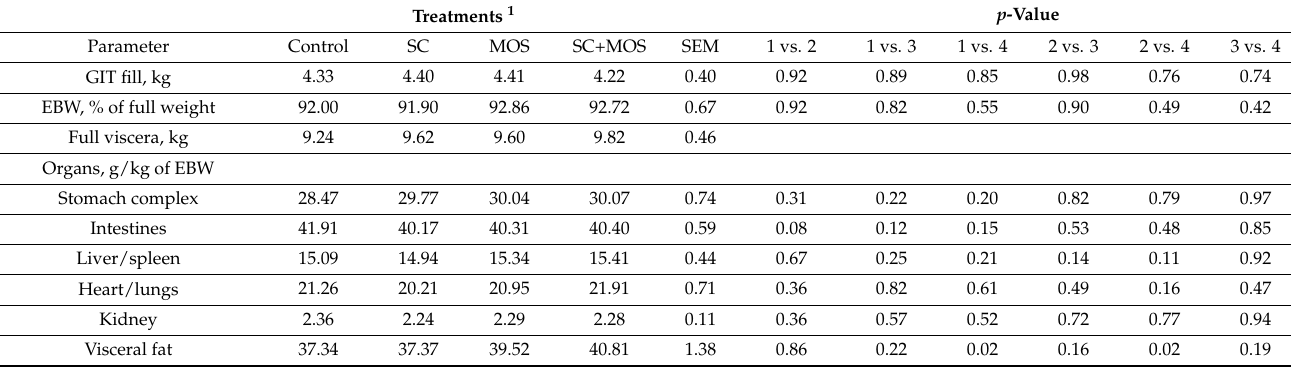
Table 6. Effect of treatments on visceral mass of finishing lambs supplemented for 93 days with eubiotics alone or combined. Treatments 1 p -Value